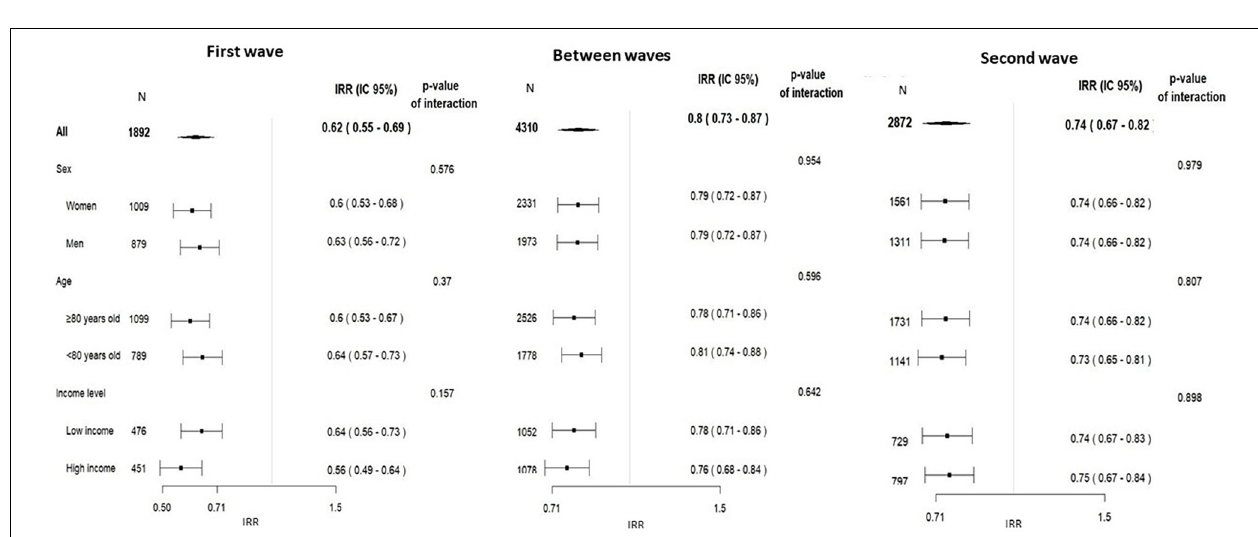
FIGURE 3 | Incidence rate ratios of acute coronary syndrome admissions, in the three predefined pandemic period vs. the corresponding pre-pandemic period (2019) by subgroups of socioeconomic factors, and the p -value for the interaction between period and each socioeconomic factor.